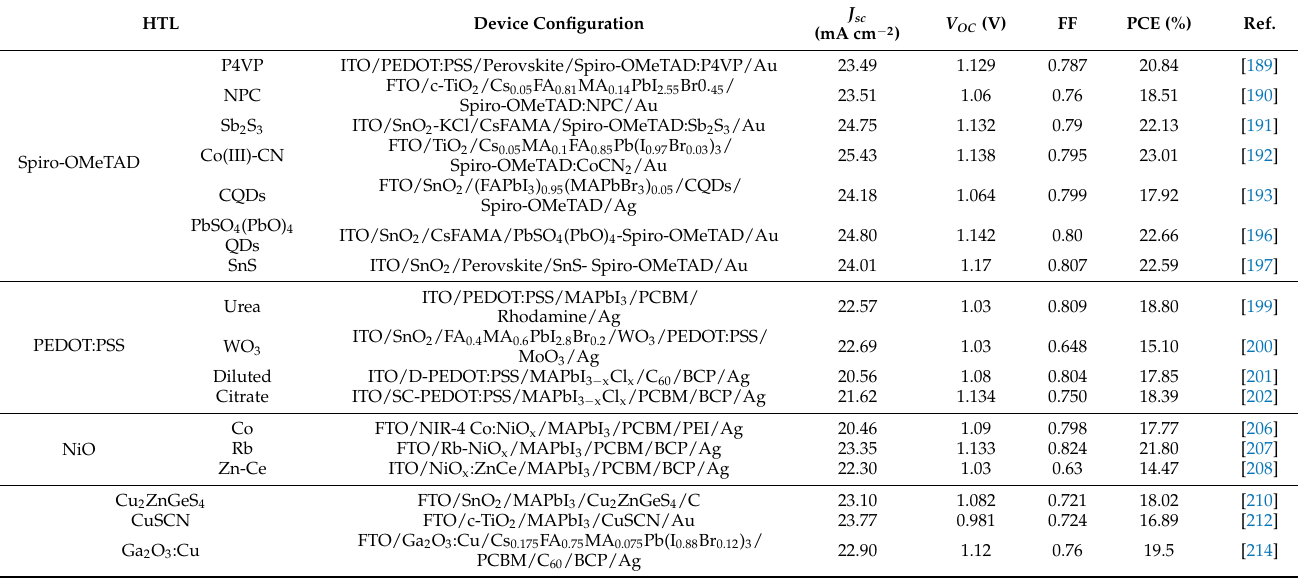
Table 3. Summary of various PSCs performances using different HTLs. Device